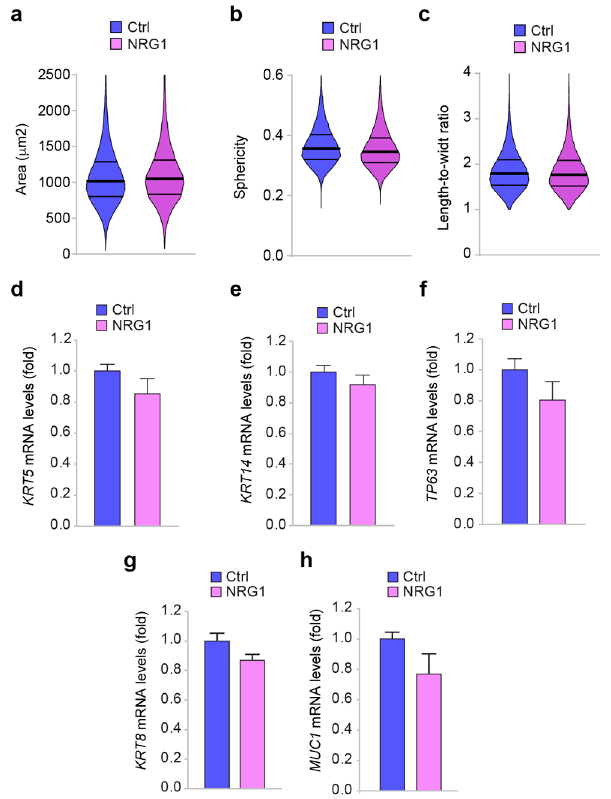
Figure 4. Administration of NRG1 β does not influence morphological parameters and the expres- sion of basal/myoepithelial and luminal differentiation markers in basal-like/triple-negative breast cells. ( a – c ) Analysis of morphological parameters, namely ( a ) cell size, ( b ) sphericity, and ( c ) length-to-width ratio in MCF10A cells cultured in vitro and treated with/without NRG1 β (10 ng/mL) for 72 h; ( d , e ) mRNA expression levels of myoepithelial/basal markers cytokeratin 5/6 ( d , KRT5 ) and cytokeratin 14 ( e , KRT14 ) in MCF10A cells cultured in vitro and treated with/without NRG1 β (10 ng/mL); ( f ) mRNA expression levels of TP63 gene in MCF10A cells cultured in vitro and treated with/without NRG1 β (10 ng/mL); ( g , h ) mRNA expression levels of luminal markers cytokeratin 8 ( g , KRT8 ), and mucin1 ( h , MUC1 ) in MCF10A cells cultured in vitro and treated with/without NRG1 β (10 ng/mL). In all panels, numerical data are presented as the mean (error bars show s.e.m.).